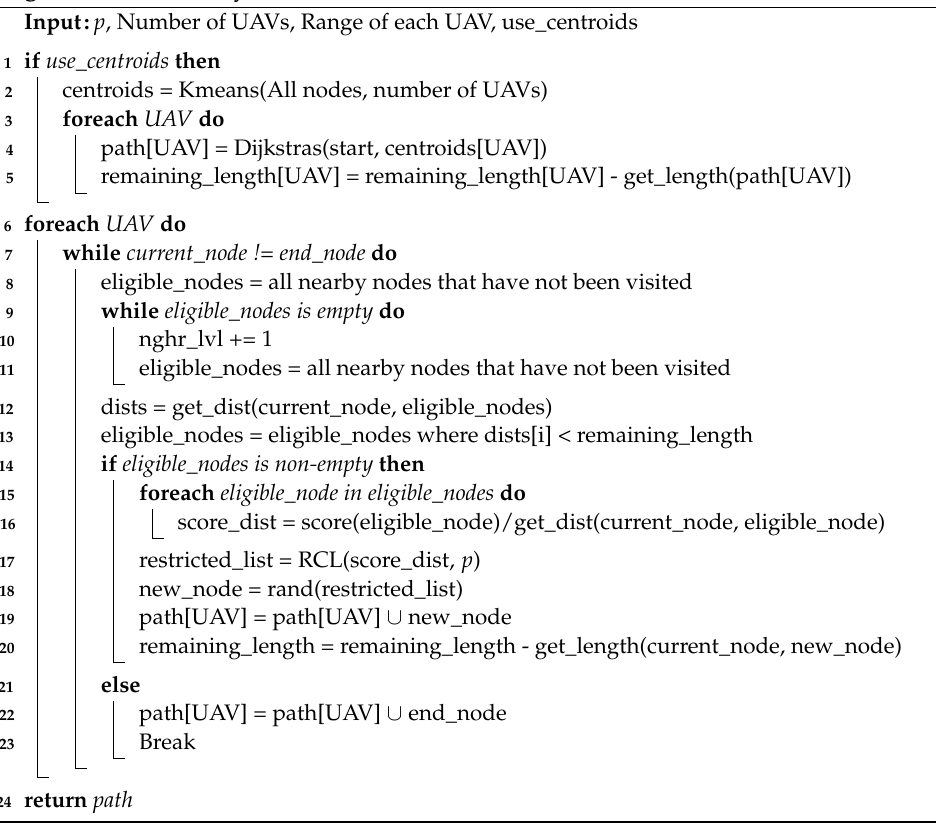
Algorithm A1: Greedy